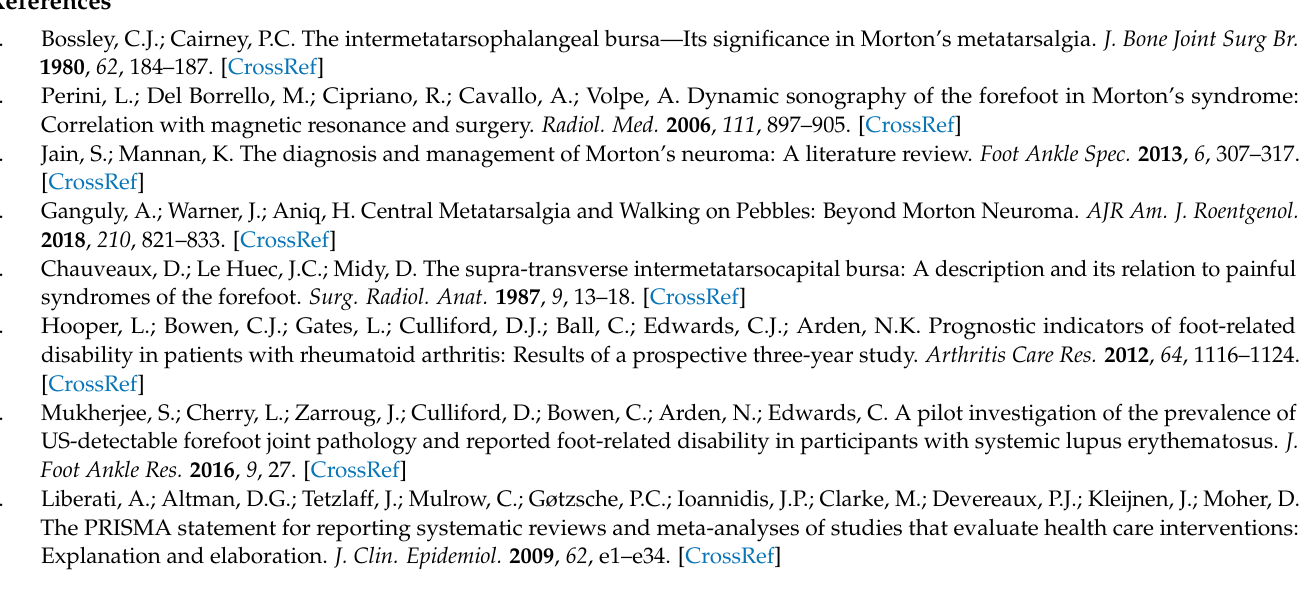
Table S2: Results from each study regarding Intermetatarsal bursitis; Table S3: Overall risk of